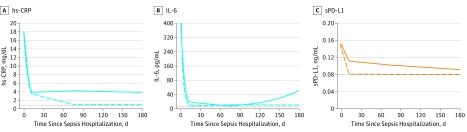
Latent Trajectory Classes for Biomarkers of Inflammation and Immunosuppression Estimated During 1 Year Using Joint Latent Class Mixture Models (JLCMM)Horizontal dotted lines represent the estimated 95th percentile of biomarker distribution among individuals without an infection. The solid and dashed lines indicate latent mean longitudinal biomarker trajectories corresponding to the 2 classes identified by separate joint latent class mixture models fit to each set of biomarker data. hs-CRP indicates highly sensitive C-reactive protein; IL, interleukin; and sPD-L1, soluble programmed death ligand 1.